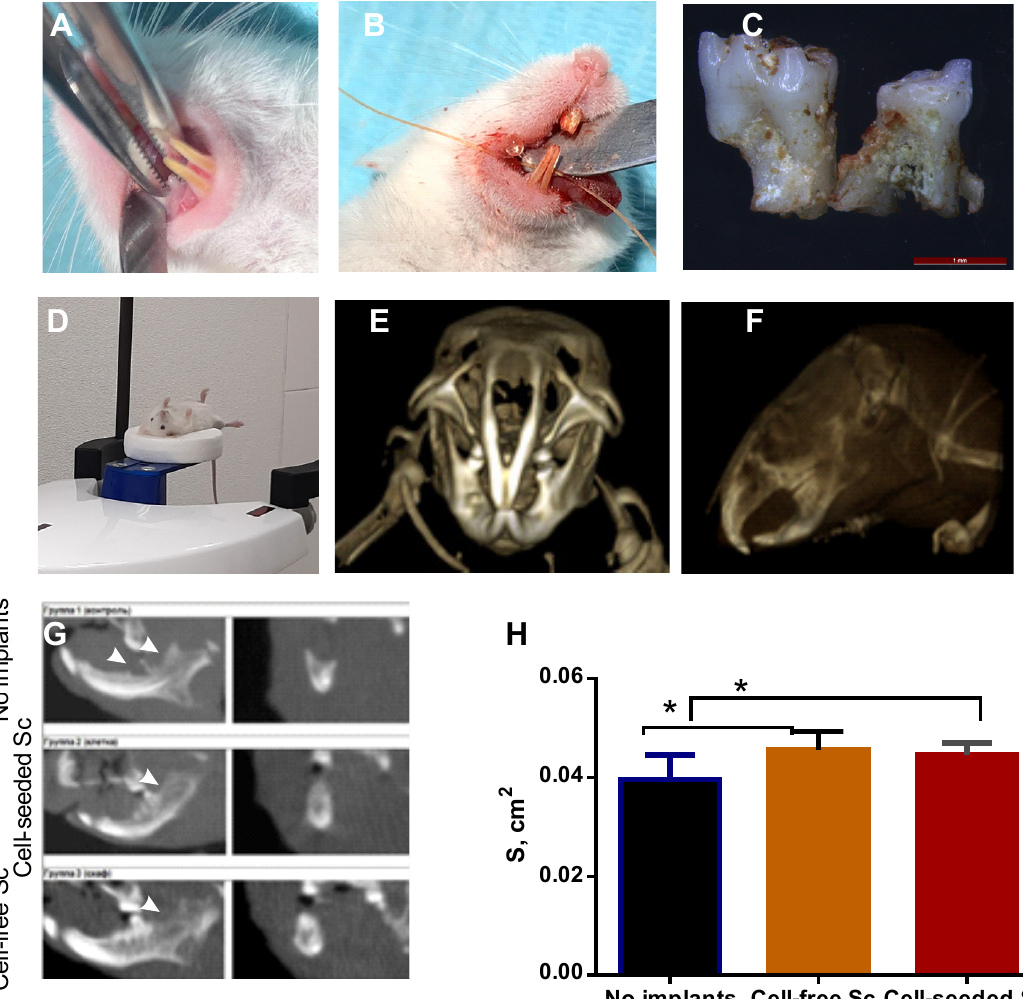
Figure 6. The Cone Beam CT analysis of the bone tissue area at the site of the defect. ( A ) The extraction of 2 molars with surrounding bone tissue to create a defect; ( B ) Wound closing with a catgut; ( C ) Molars extracted a fragment of the alveolar bone (between the roots); ( D ) A mouse in a cone beam CT scanner; ( E ) A Volume Rendering (VR) of a mouse skull, and ( F ) MIP reconstruction; ( G ) MPR images (left: sagittal, right: coronal) of the alveolar bone with a defect (pointed by arrows), in which the different size of the alveolar bone in the no-implant group and the groups with implants is visualized; ( H ) A diagram of the bone tissue area evaluation at the site of the defect in three groups of animals. * p < 0.05 vs. no implant group; Y-axis: the area of bone tissue, cm 2 .